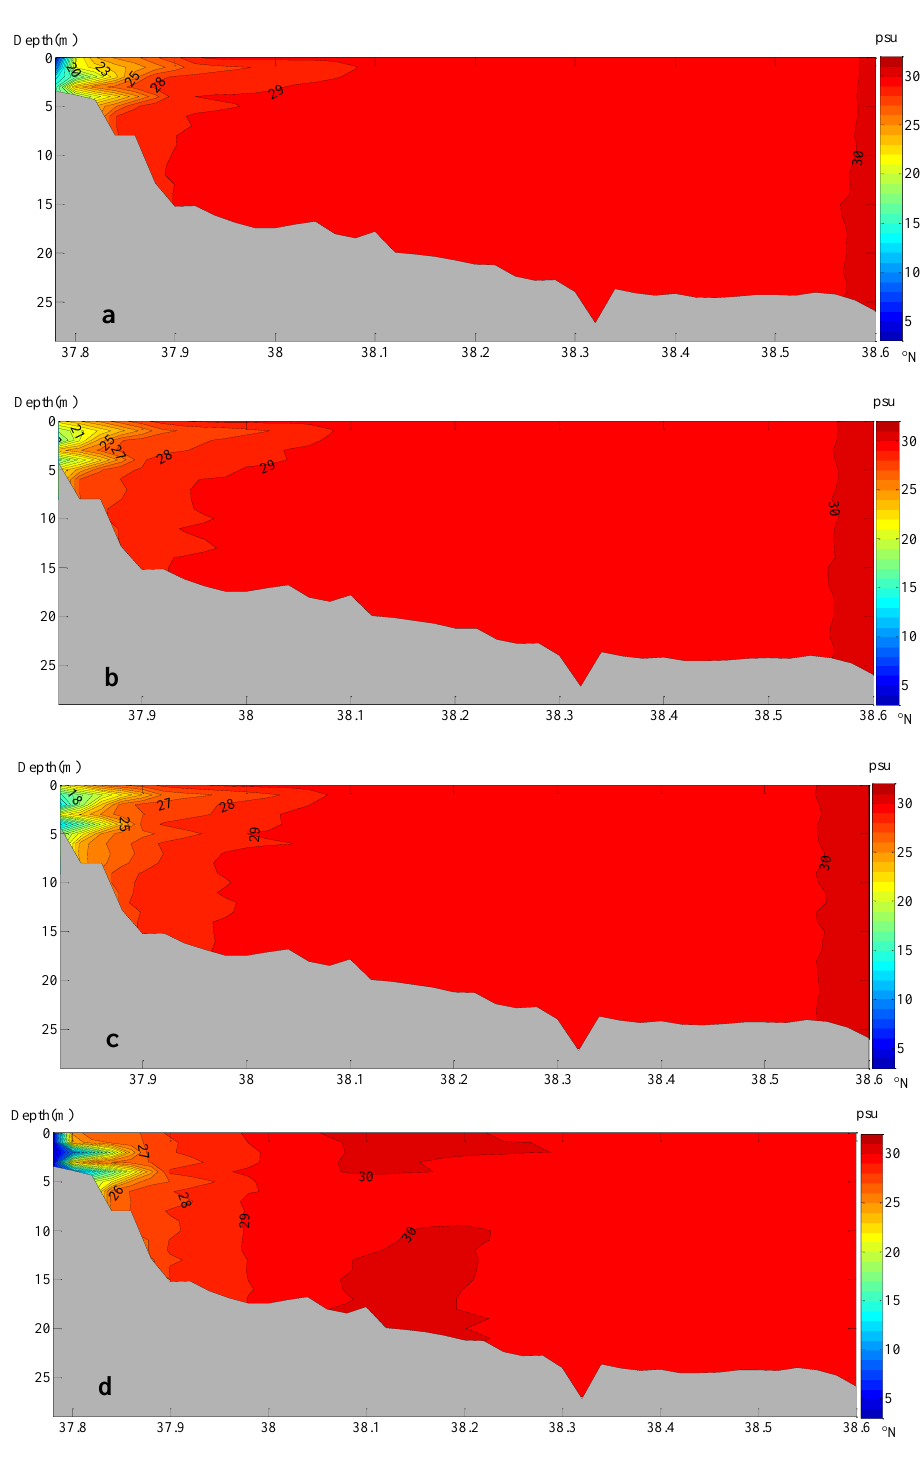
Figure 17. Vertical salinity distribution at different wind speeds in the dry season (( a ): case 3, ( b ): case 4, ( c ): case 5, ( d ): case 6).